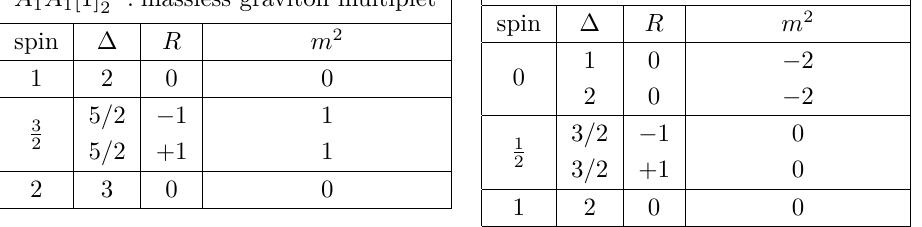
Table 4 . Massless N = 2